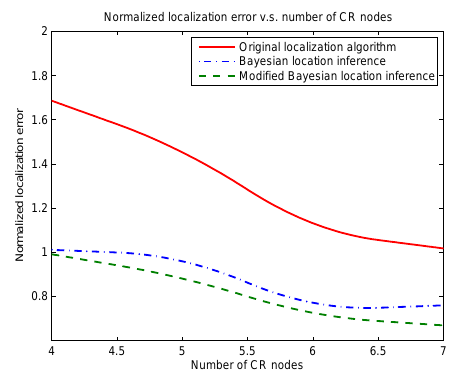
Figure 9. Comparison of localization algorithms at different numbers of CR nodes.